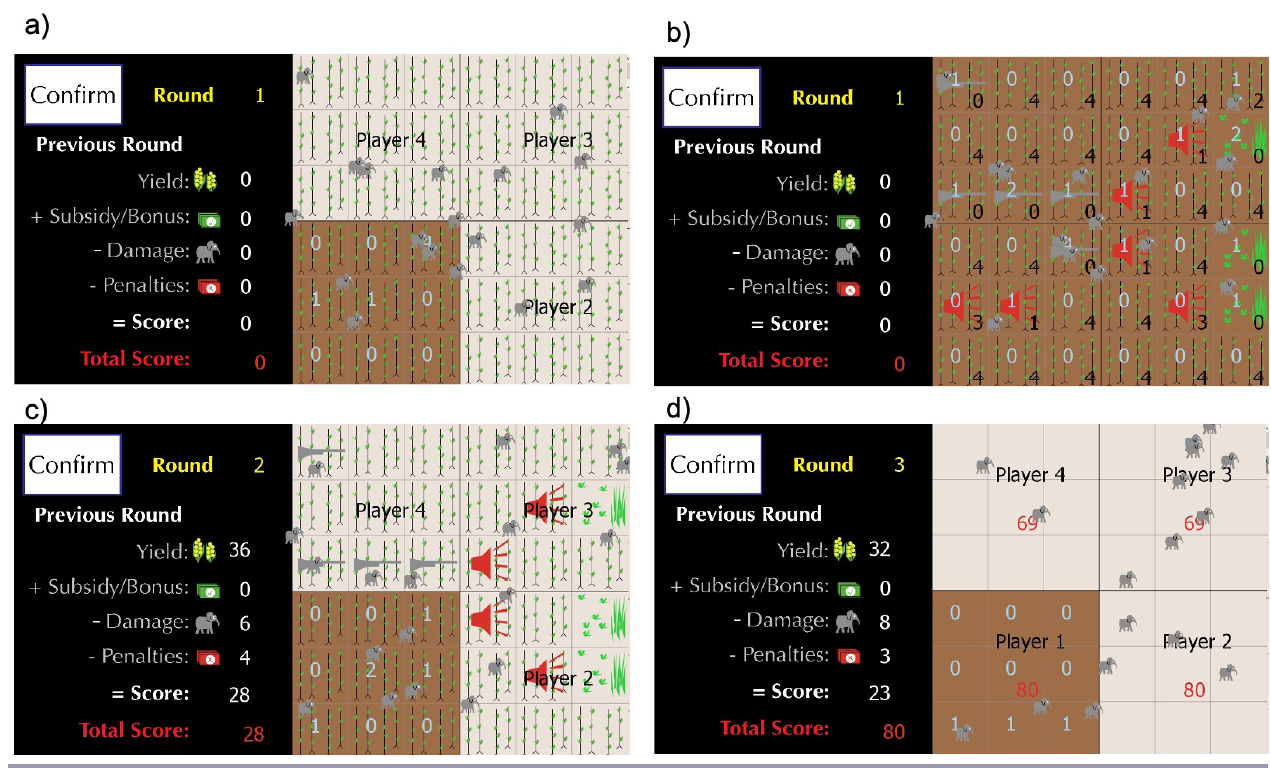
Fig. 2. Images of the game screen (English version) showing how the game proceeds. See Fig. 3 for game parameters. (A) The bottom left corner of the landscape is the active player at round 1; elephants are randomly distributed across the landscape, and the white number on each cell indicates the number of elephants. (B) Game screen of the active player after all four players have made decisions. (C) Game screen at the start of round 2; actions taken by other players in the previous turn are visible to all. The score of the active player in the previous round is shown on the left side of the panel. (D) Game screen showing the total score for each player at the end of practice